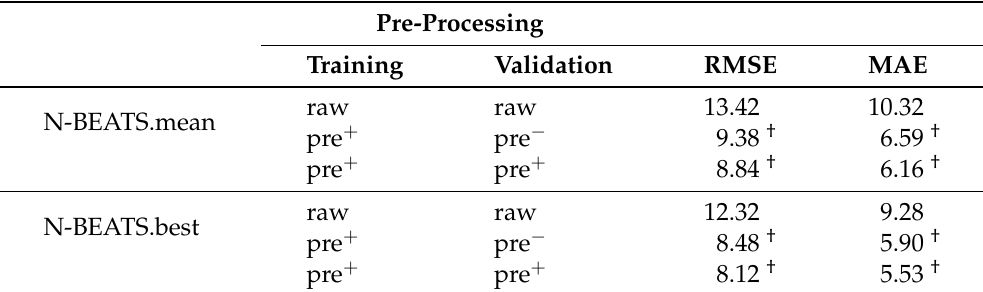
Table 5. Results with pre-processing of meals (pre) vs. original raw data for meal events (raw), for the carbohydrate recommendation scenario Carbs ( ± b ) on unrestricted examples. pre + refers to using all pre-processed meals (shifted original meals and added meals), whereas pre − does not use meals added by the pre-processing procedure. We show results for different combinations of pre-processing options during Training and evaluation on Validation data, e.g., the first row indicates raw data were used during both training and evaluation. The symbol † indicates a p -value < 0.03 when using a one-tailed t -test to compare against the results without pre-processing (raw).